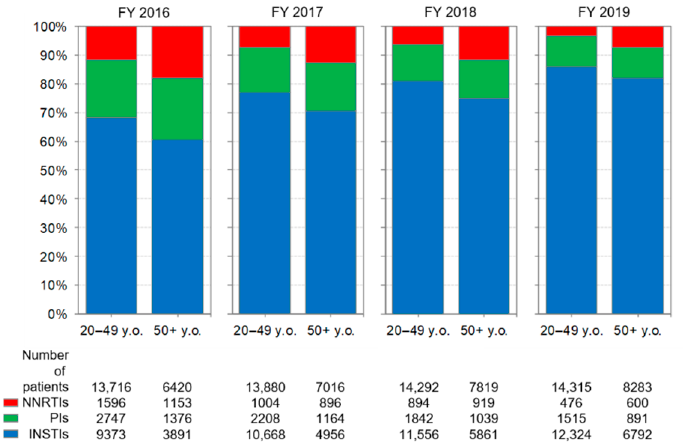
Figure 5. Changes in the prescriptions of anchor drugs by age group. The analysis was performed on drugs listed in Table 1. NNRTI: non-nucleoside reverse transcriptase inhibitor, PI: protease inhibitor, INSTI: integrase strand transfer inhibitor.